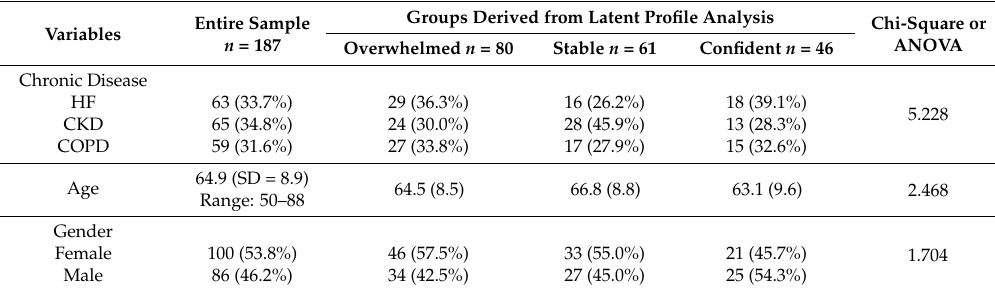
Table 2. Sample characteristics and group